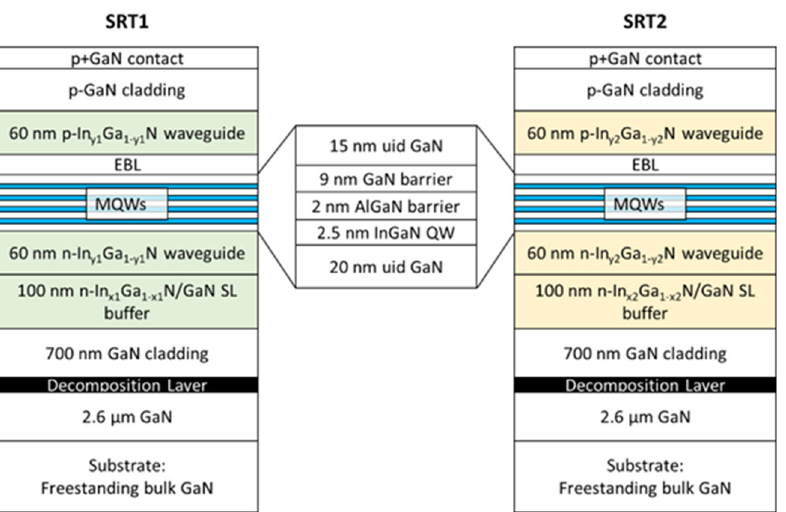
Figure 1. Schematic of the SRT LD epitaxial design. Indium composition in buffer and waveguide is denoted as x, y, and the numbers correspond to SRT1 or SRT2, respectively.